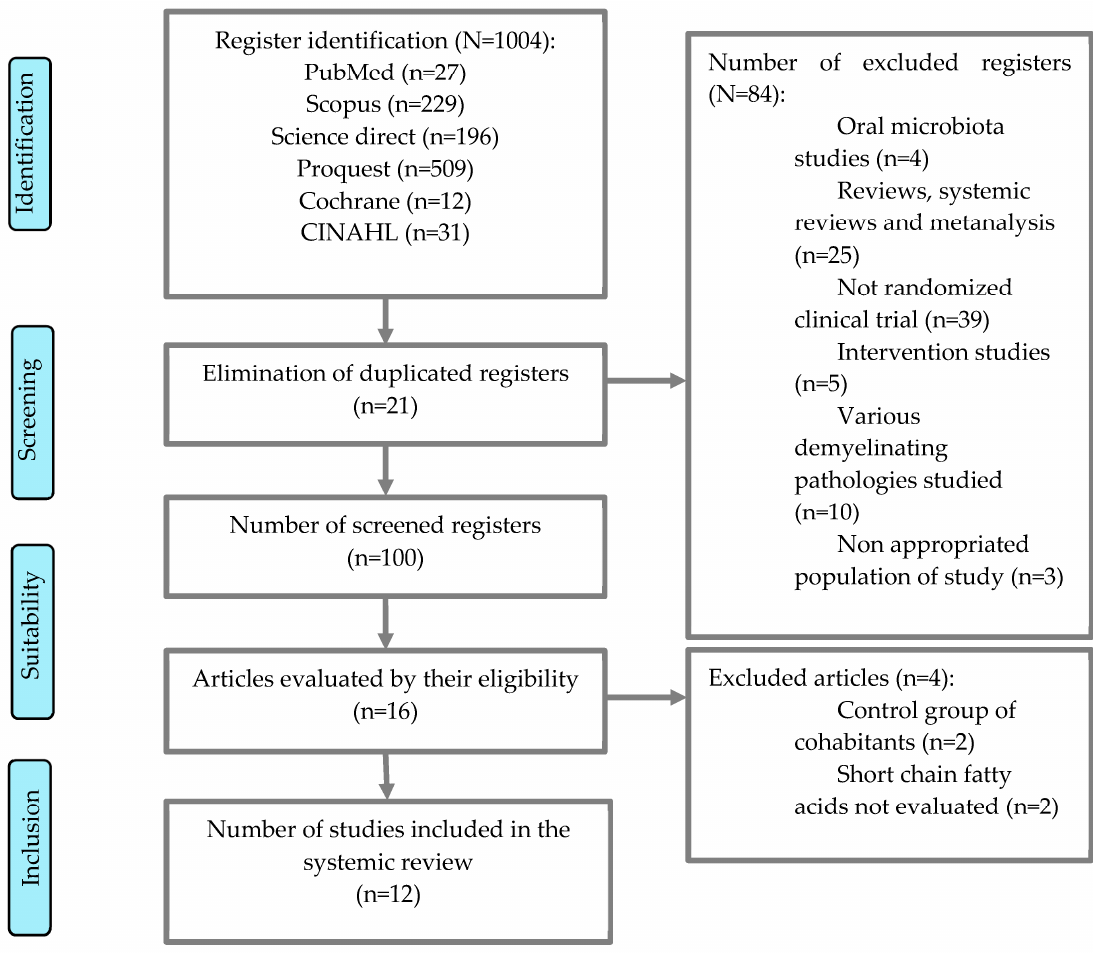
Figure 1. Flowchart. Figure 1.